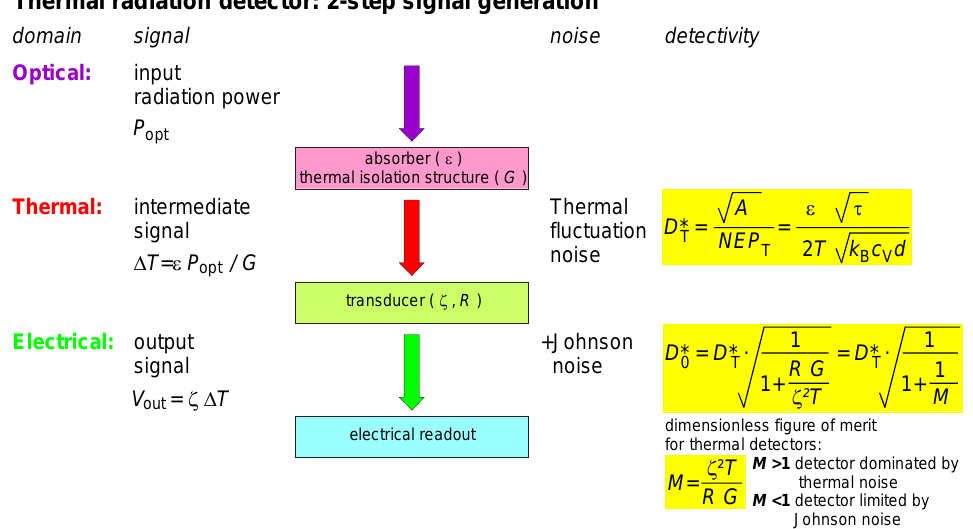
Figure 1. Illustration of the sensing principle of thermal radiation detectors including the signal generation, the main sources of noise, and the resulting specific detectivity.